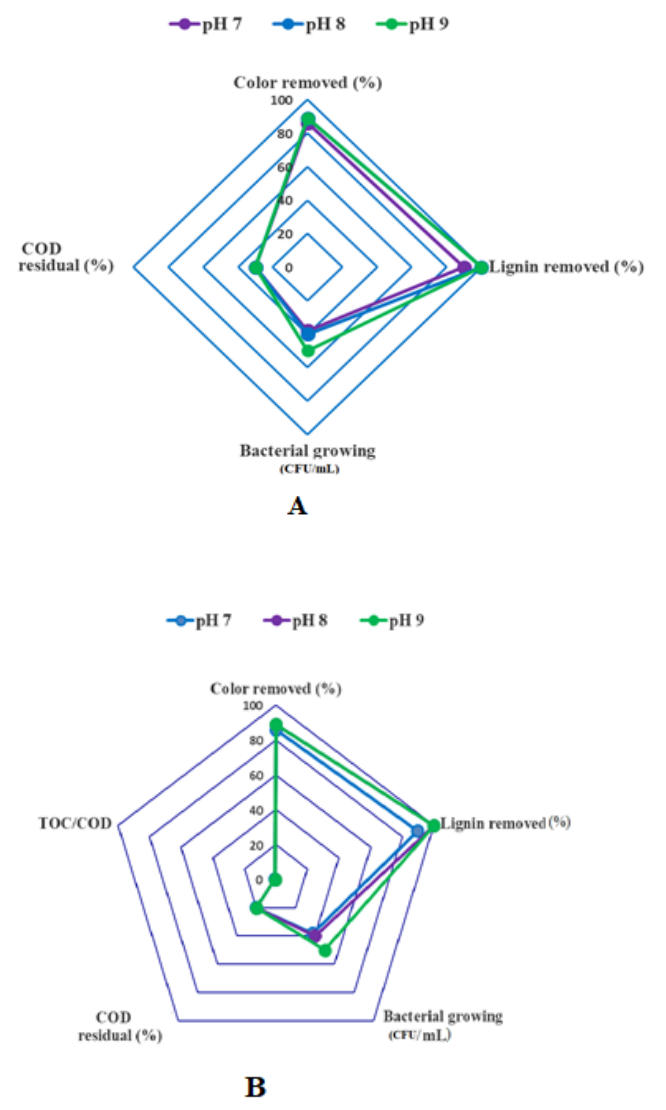
Figure 8. Relation between the parameters studied in the optimization of lignin degradation by RGM2262.